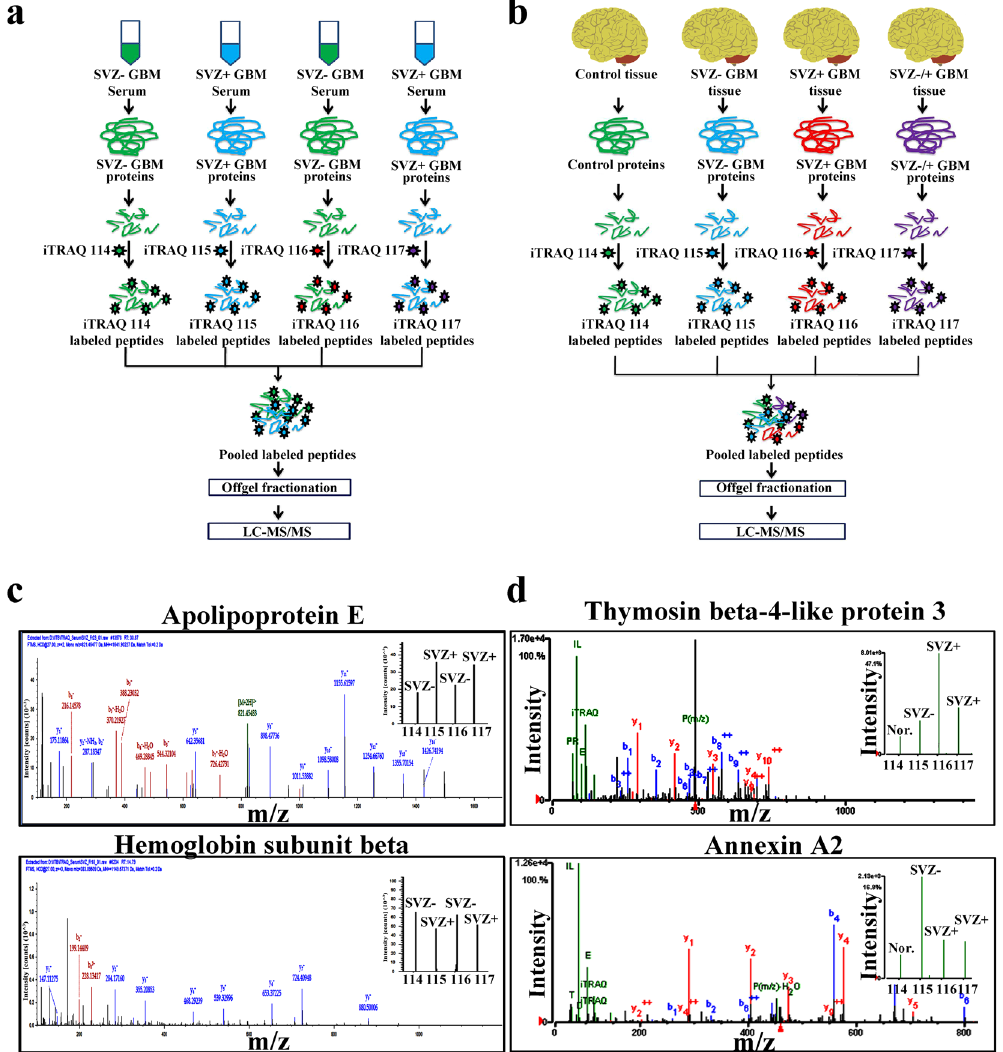
Figure 2. Quantitative serum and tissue proteomic analysis of SVZ + and SVZ − GBMs. Schematic of iTRAQ based proteomic analysis of ( a ) serum and ( b ) tissue specimens for the identification of quantitative proteomic alterations. ( c ) Serum proteomic analysis of SVZ + (n = 12) and SVZ − (n = 12) GBMs was performed using iTRAQ method. Representative mass spectra for one of the highly up-regulated (apolipoprotein E) and down- regulated (hemoglobin subunit beta) proteins in SVZ + GBMs (w.r.t SVZ − GBMs). ( d ) Tissue proteomic analysis of SVZ + (n = 6) and SVZ − (n = 6) GBMs was performed using iTRAQ approach. Representative mass spectra of two differentially expressed proteins, thymosin beta-4-like protein 3 and annexin A2 in SVZ + GBM tumors (w.r.t SVZ − GBMs). Relative abundance of thymosin beta-4-like protein 3 and annexin A2 protein are shown in the inset as the intensities of iTRAQ reporter